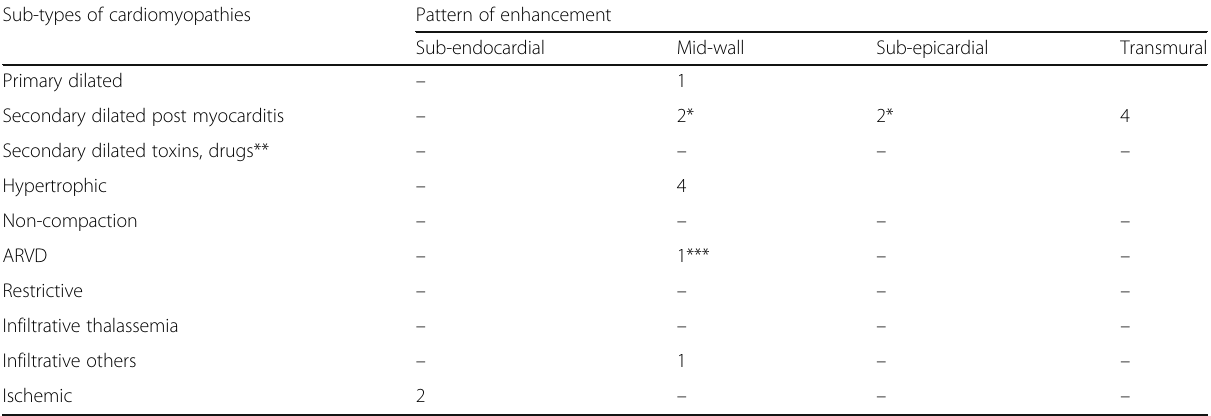
Table 4 Pattern of LGE in study groups Sub-types of cardiomyopathies